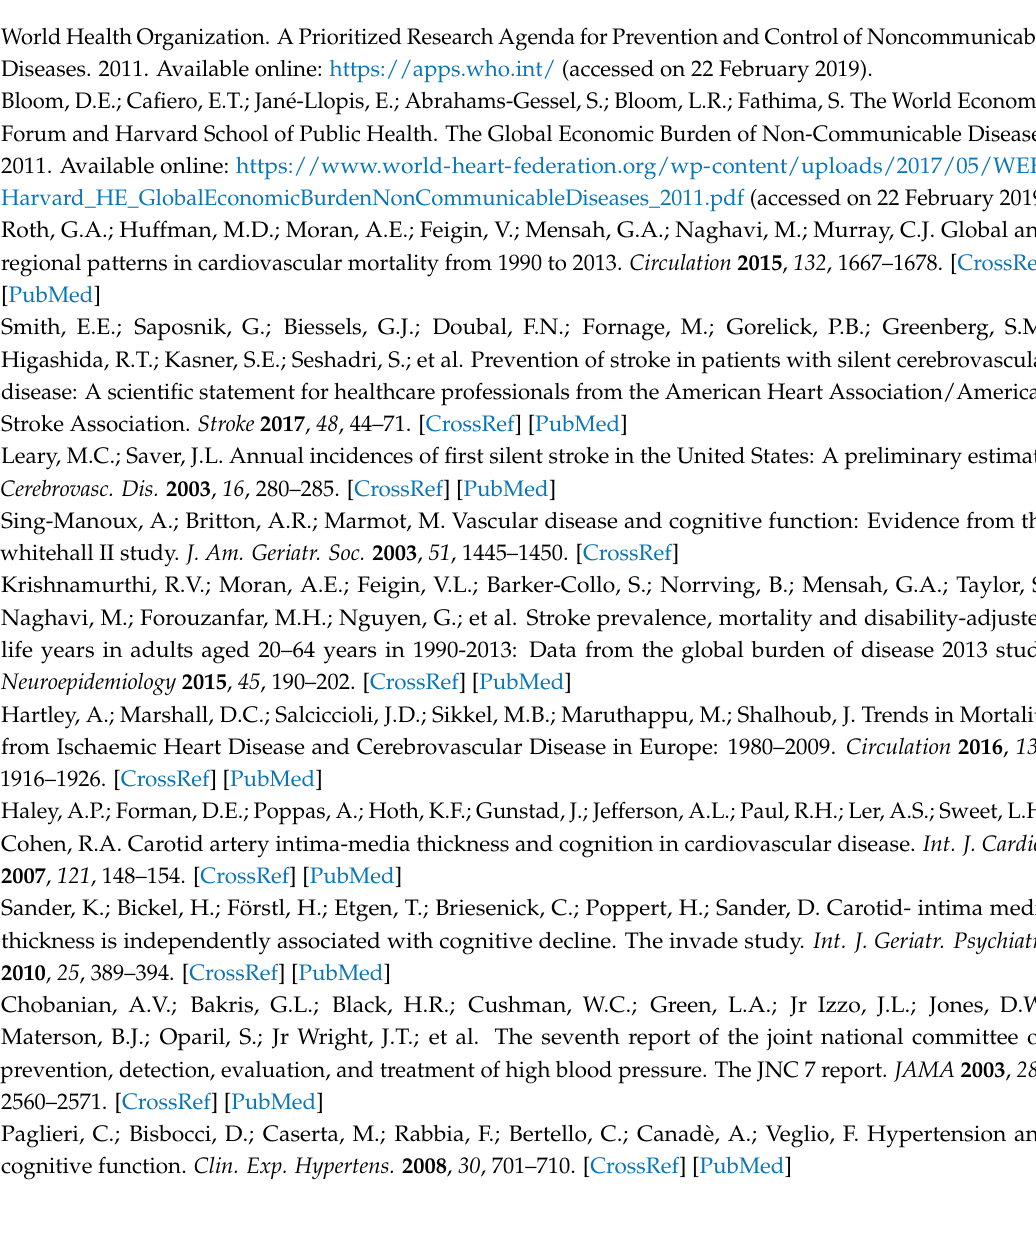
Table S1: Data Extraction